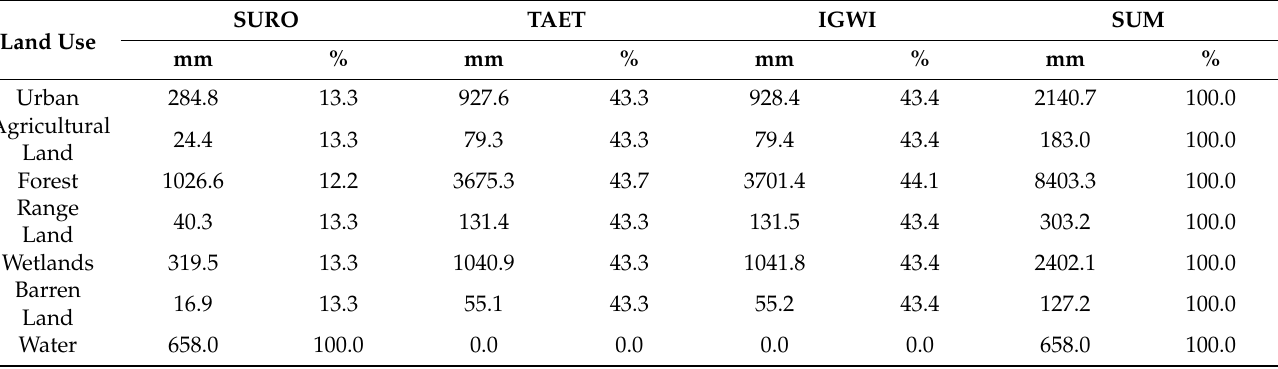
Table 7. Hydrologic components for each land use from Scenario 2.